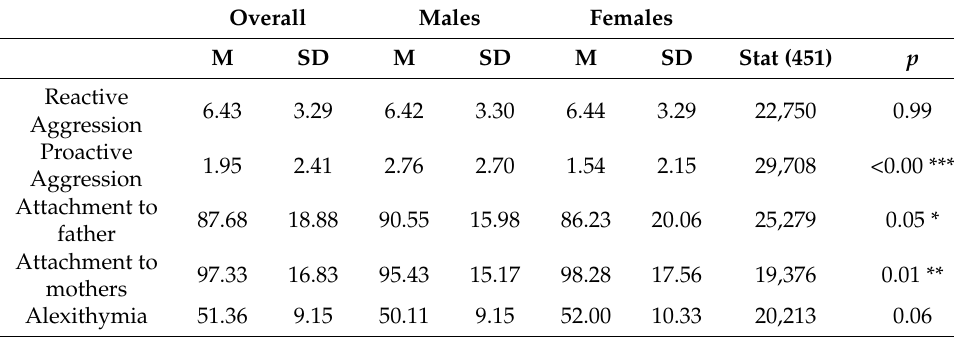
Table 1. Variables’ mean and standard deviation, and Mann–Whitney U test results.